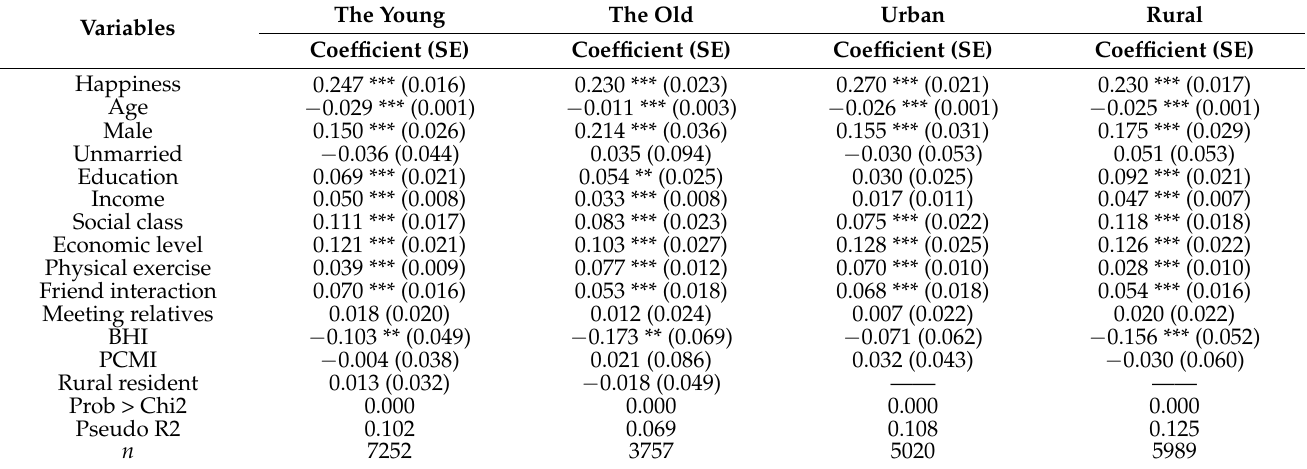
Table 5. Ordered probit regression results by age and resident type. Dependent variable: self-rated